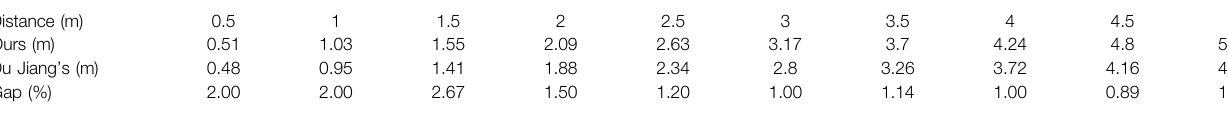
TABLE 1 | Measurement results. Distance